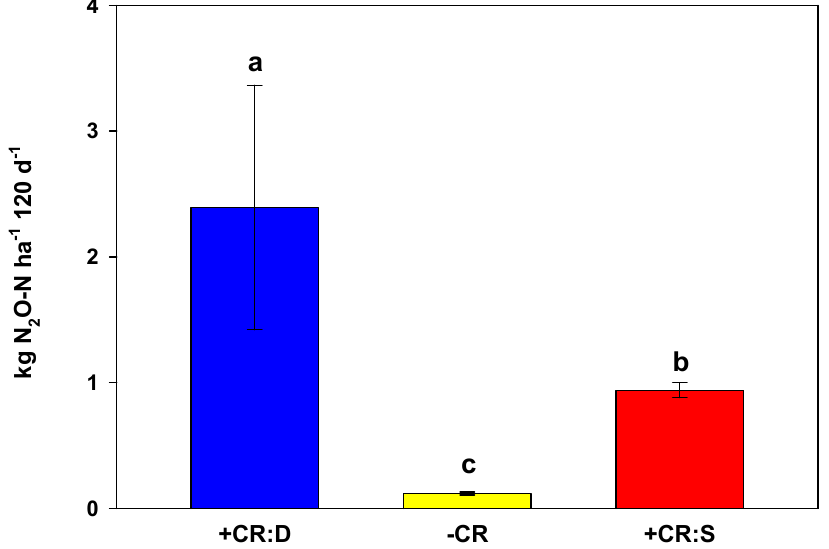
Figure 2. Mean cumulative N 2 O emission (n = 4 ± standard error) over the experimental period of 120 days as affected by sugar beet residue management. +CR:D = residues ploughed in, − CR = residues removed from the field and +CR:S = residues surface applied after ploughing. Means followed by a common letter refer to Log 10 transformed data and are not significantly different by the Student– Newman–Keuls Test at the 5% level of significance